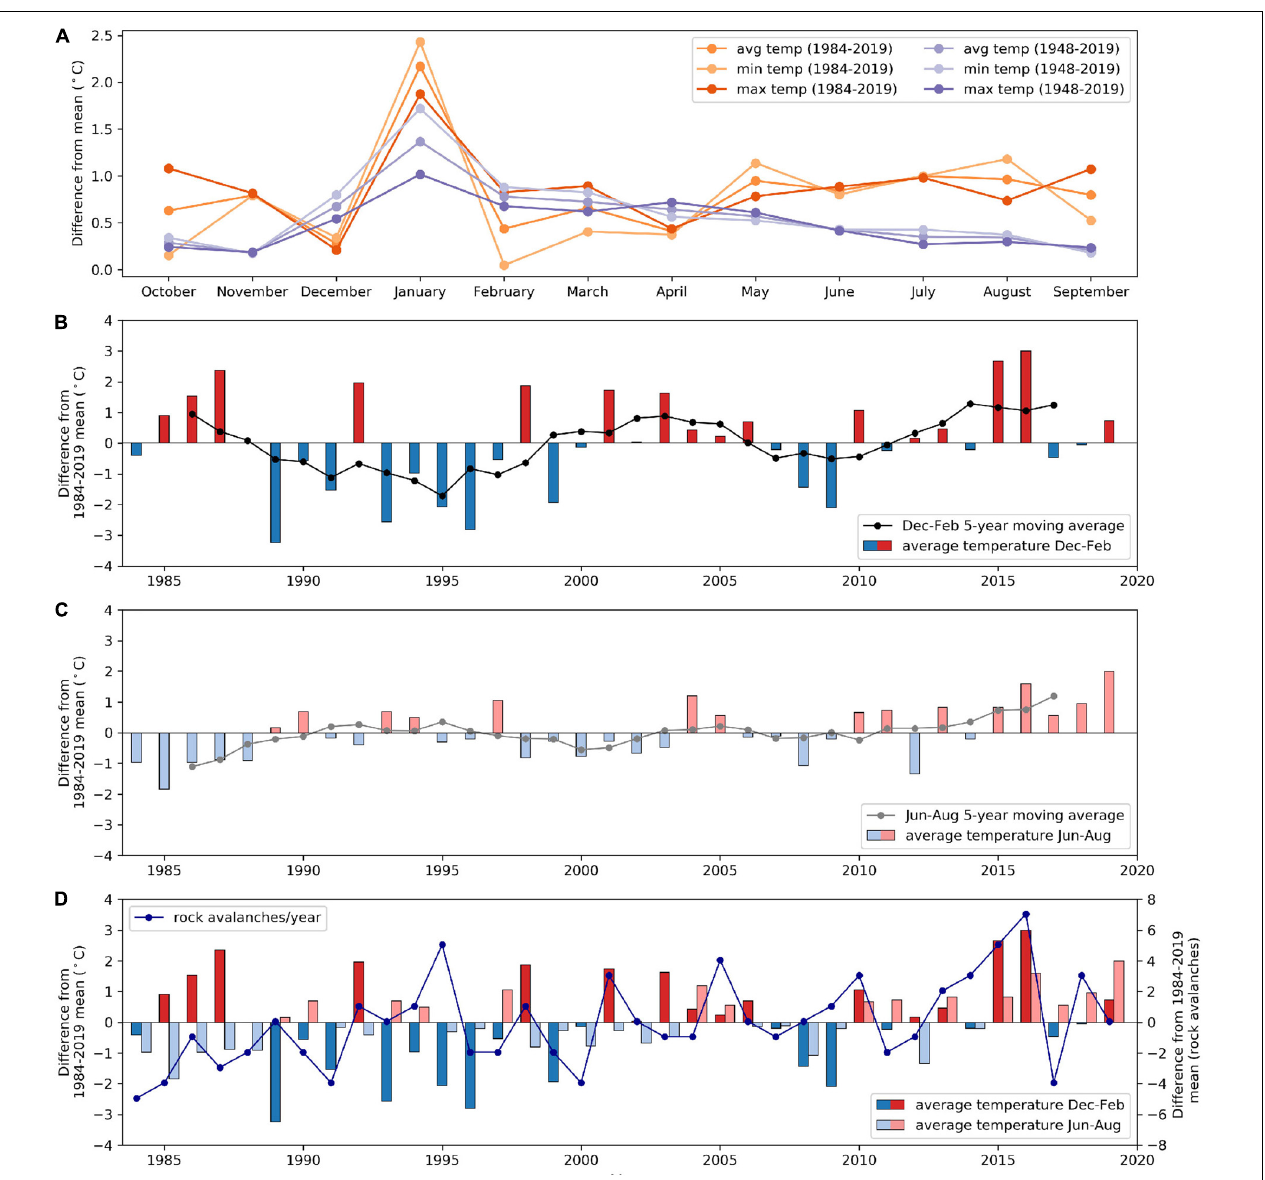
FIGURE 12 | (A) Deviations from the 1948–2019 (purple) and 1984–2019 (orange) mean monthly temperatures (average, minimum and maximum) at the Yakutat Airport weather station in southern Alaska. Difference from 1984 to 2019 mean temperature for average (B) winter (December-February) and (C) summer (June-August) temperatures. (D) Comparison of the number of rock avalanches per year and average winter (December-February) and summer (June-August) temperatures during the period from 1984 to 2019 in the Saint Elias study area. Rock avalanche data do not include possible earthquake-triggered events (three) and each two-part failure is only counted